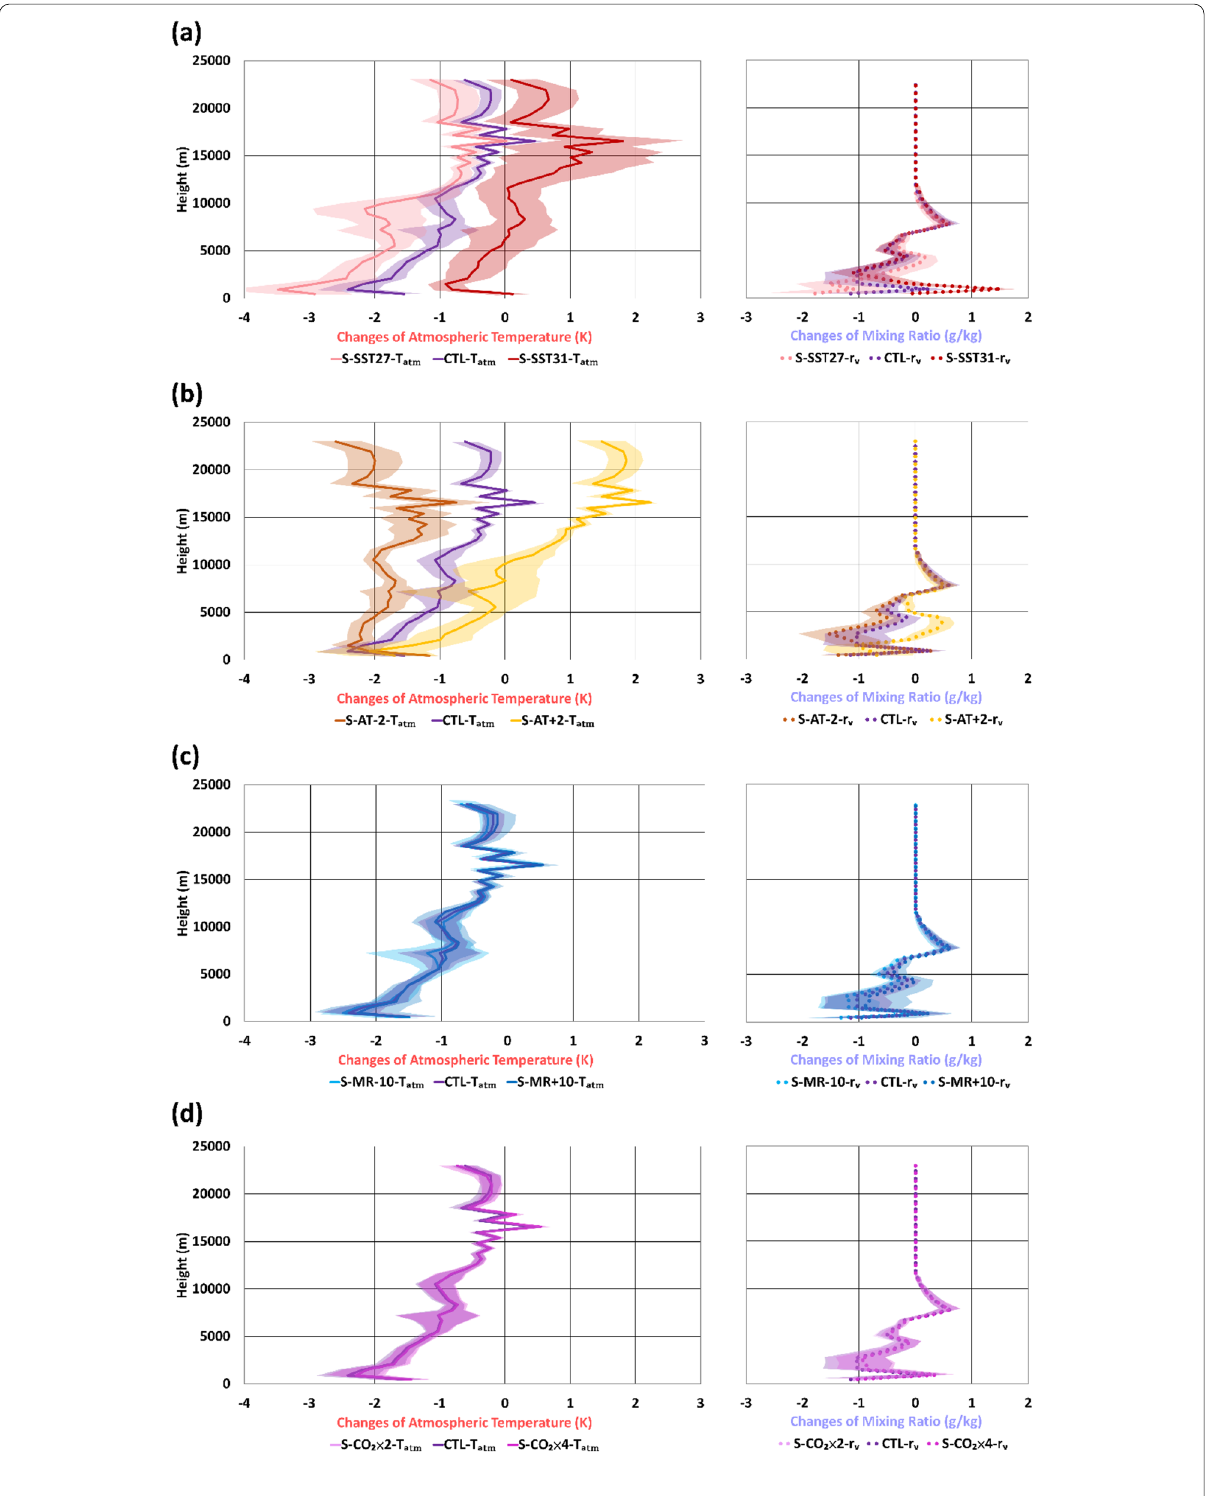
Fig. 1 The mean state (bold line) and standard deviation (shaded) from 0 to 336 h in azimuthal average at 1000 km distance from the TC center for vertical profile of T atm and r v in the following sensitivity experiments: a S‑SST, b S‑AT, c S‑MR, and d S‑CO2, are calculated as differences from the Jordan (1958) sounding